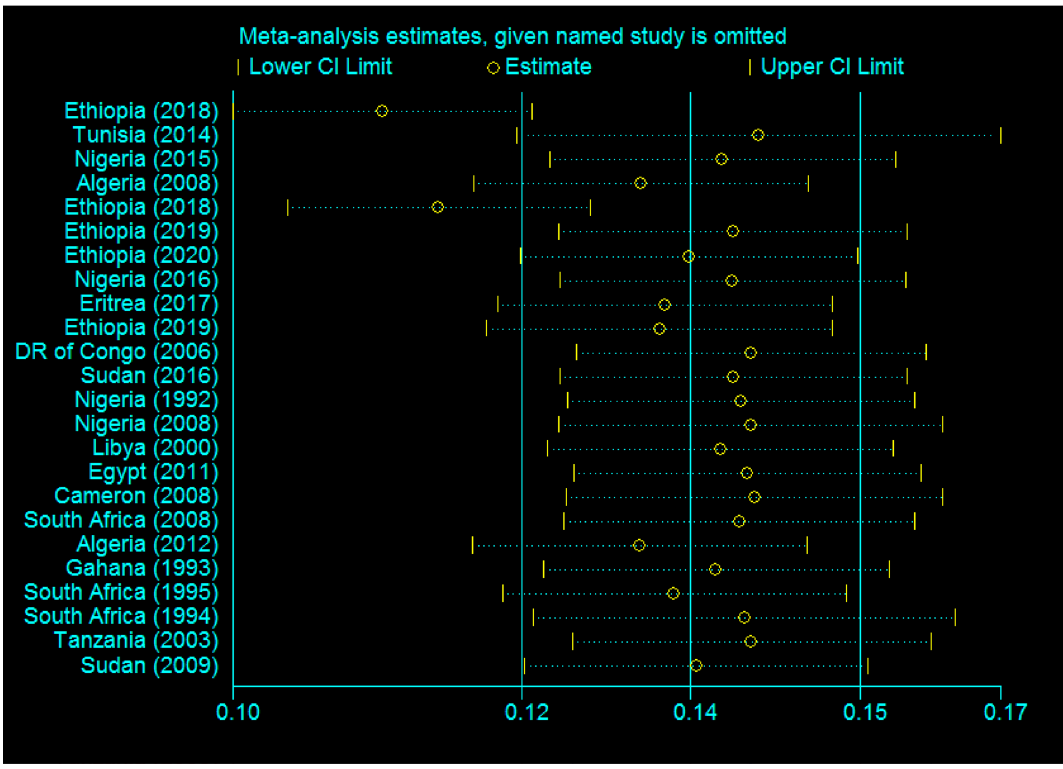
Figure 5. Sensitivity analysis to see the influence of each study in Africa, 2020.